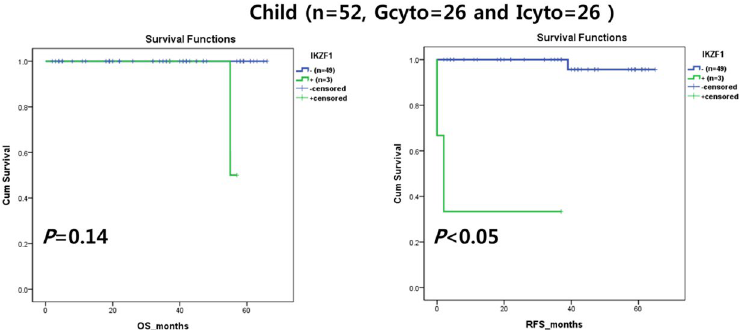
Figure 4. Clinical outcomes by IKZF1 alteration. IKZF1 alteration had a prognostic impact on overall survival (OS) and relapse-free survival (RFS) in child B-cell lymphoblastic leukemia/lymphoma (B-ALL), particularly in the good cytogenetic (Gcyto) and intermediate cytogenetic risk (Icyto) groups. Child B-ALL were classified into Gcyto (n = 26) and Icyto (n = 26)